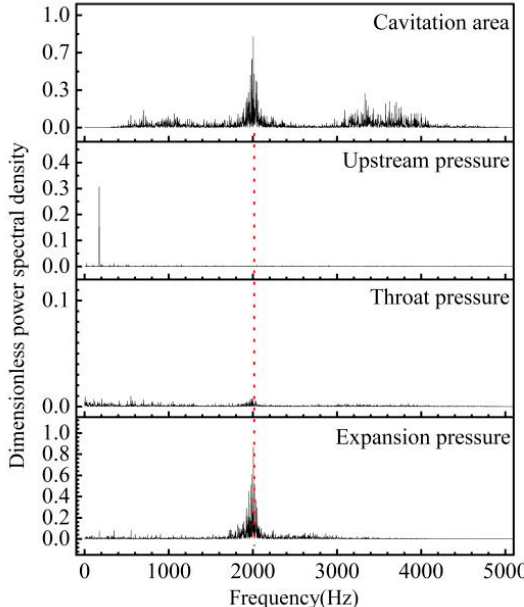
Figure 7. Power spectral density distribution of the pressure pulsation and the variation of cavitation area at the three measuring points.